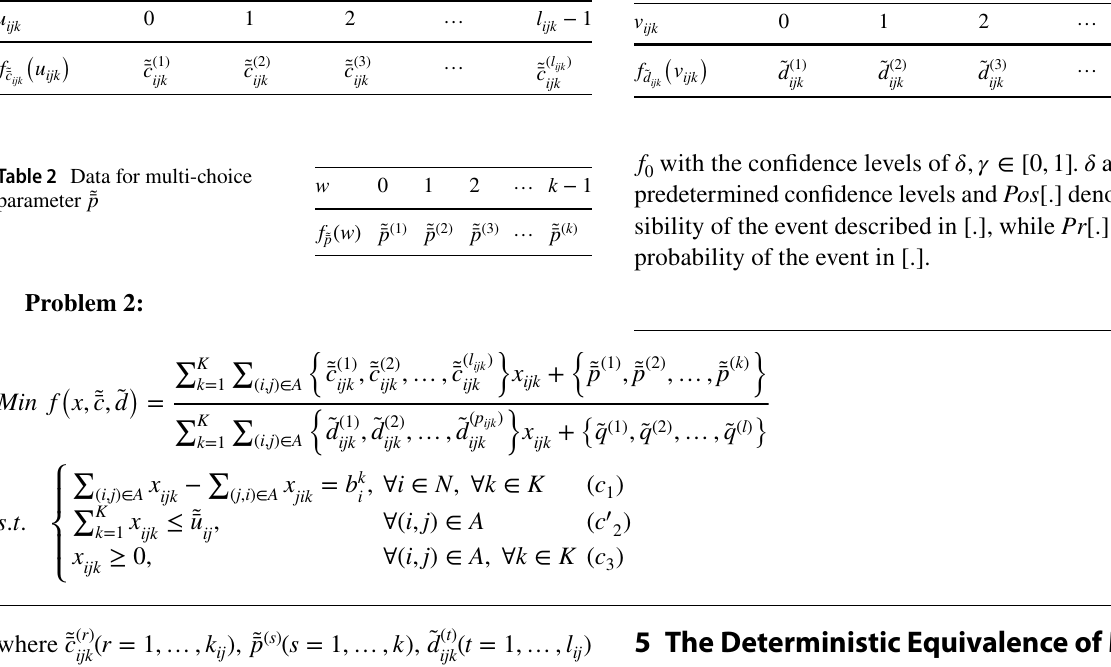
Table 1 Data for multi-choice parameter ̃̄ c ijk